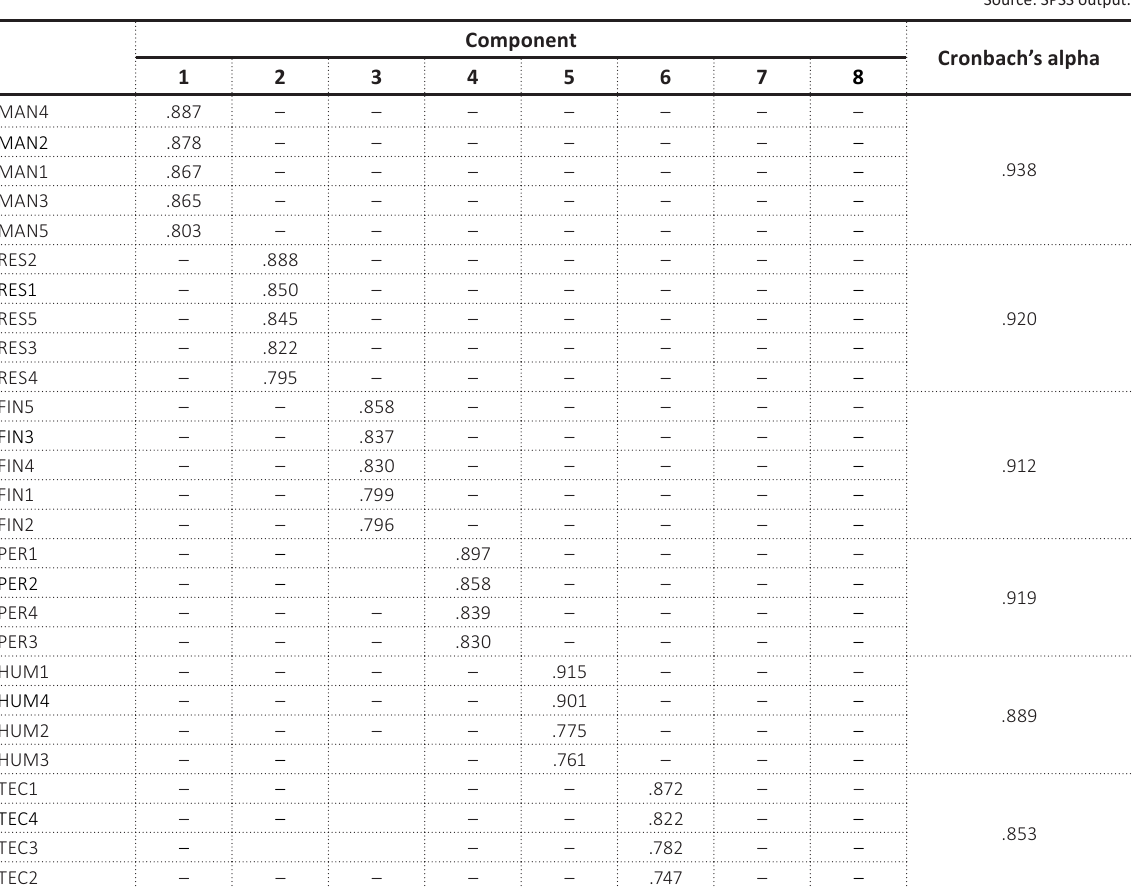
Table 3. Rotated component matrix and Cronbach’s alpha